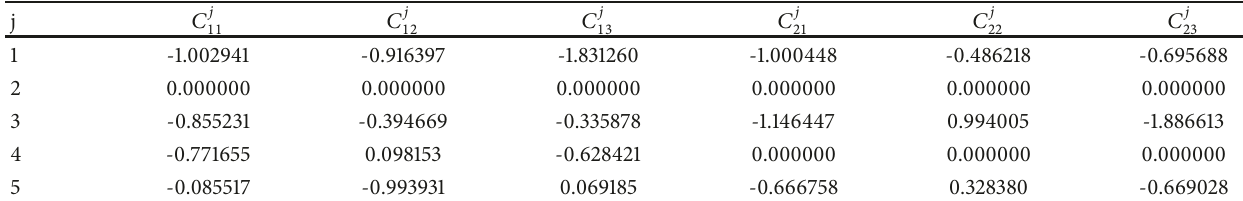
Table 4: Values of the control parameters 𝐶 𝑖𝑗 .